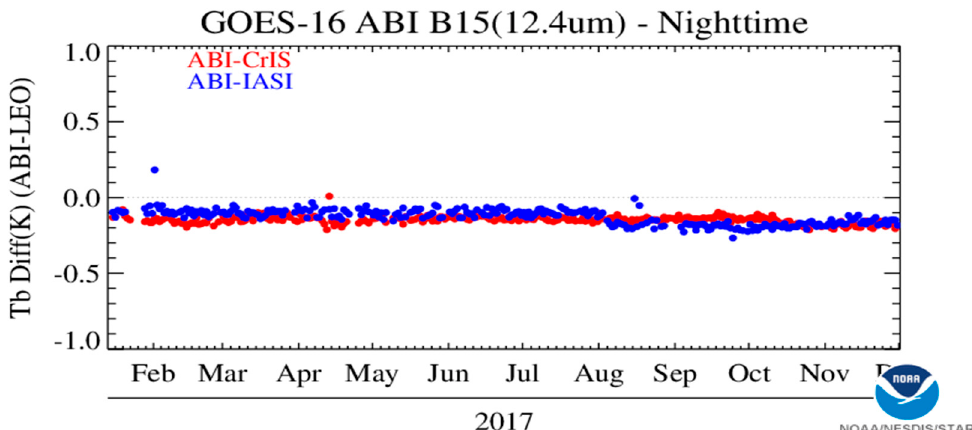
Figure 16. Difference of radiance, expressed in terms of brightness temperature (Tb in K), plotted as a function of time since the ABI data were received in January 2017. The red and blue dots are ABI differences from CrIS and IASI, respectively.